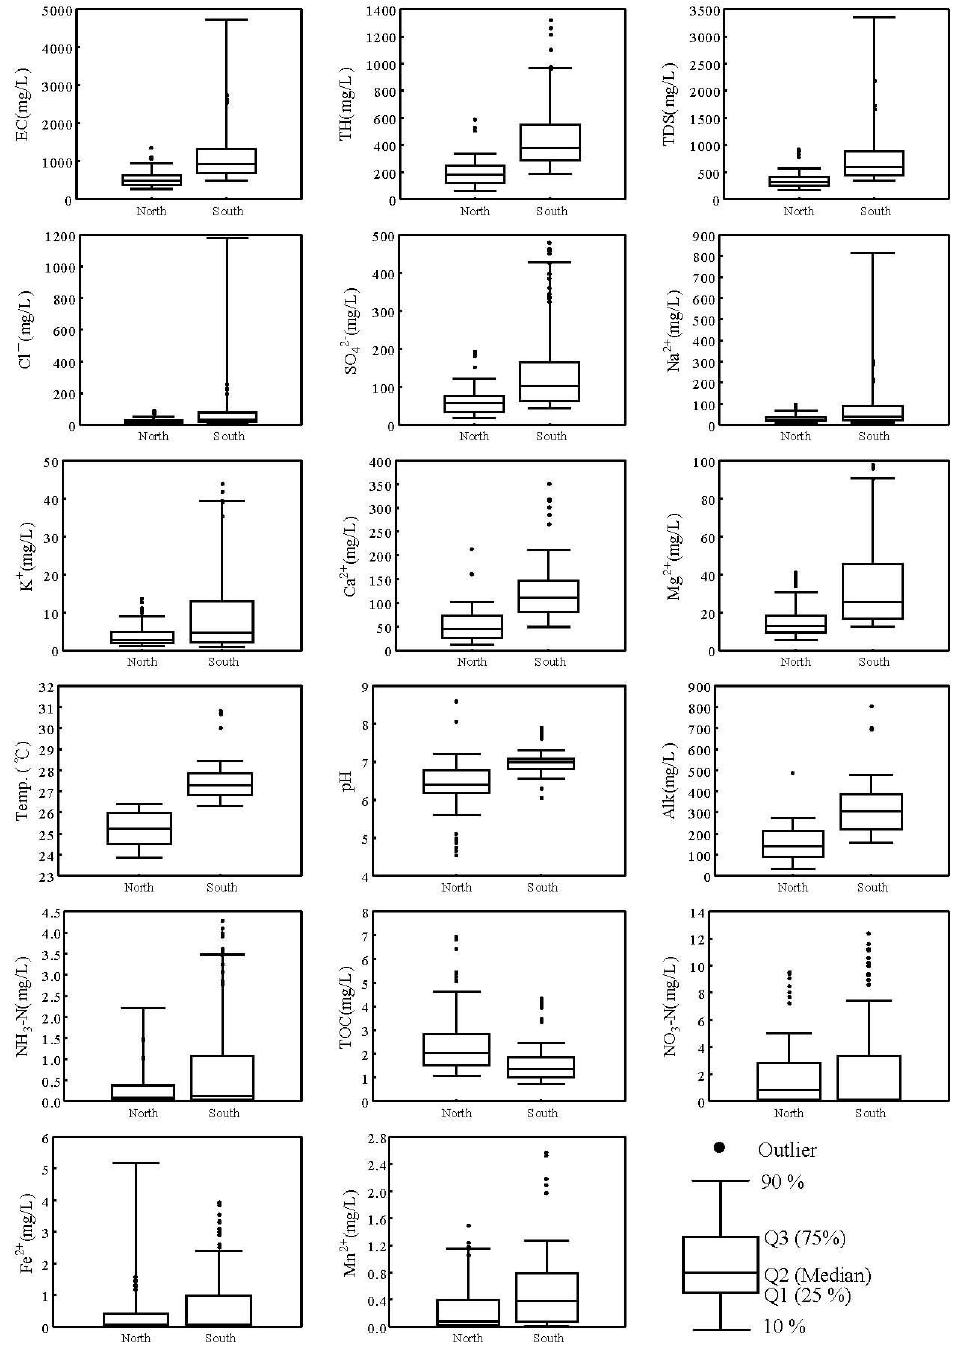
Figure 3. The box-and-whisker plot of various hydrochemical parameters for the northern and southern areas in